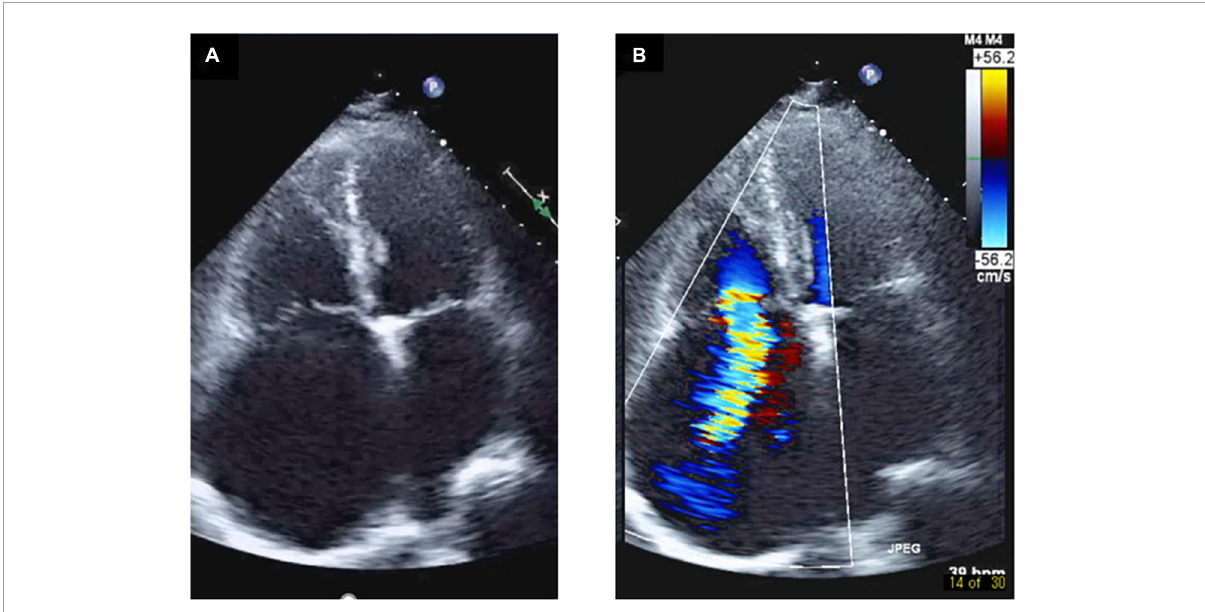
FIGURE1 Right atrium enlargement and severe tricuspid regurgitation in a transthoracic echocardiography. Transthoracic echocardiography shows enlargement of the right atrium and a gap between the septal leaflet and anterior leaflet (A) , and severe tricuspid regurgitation was pointed out from the gap (B)